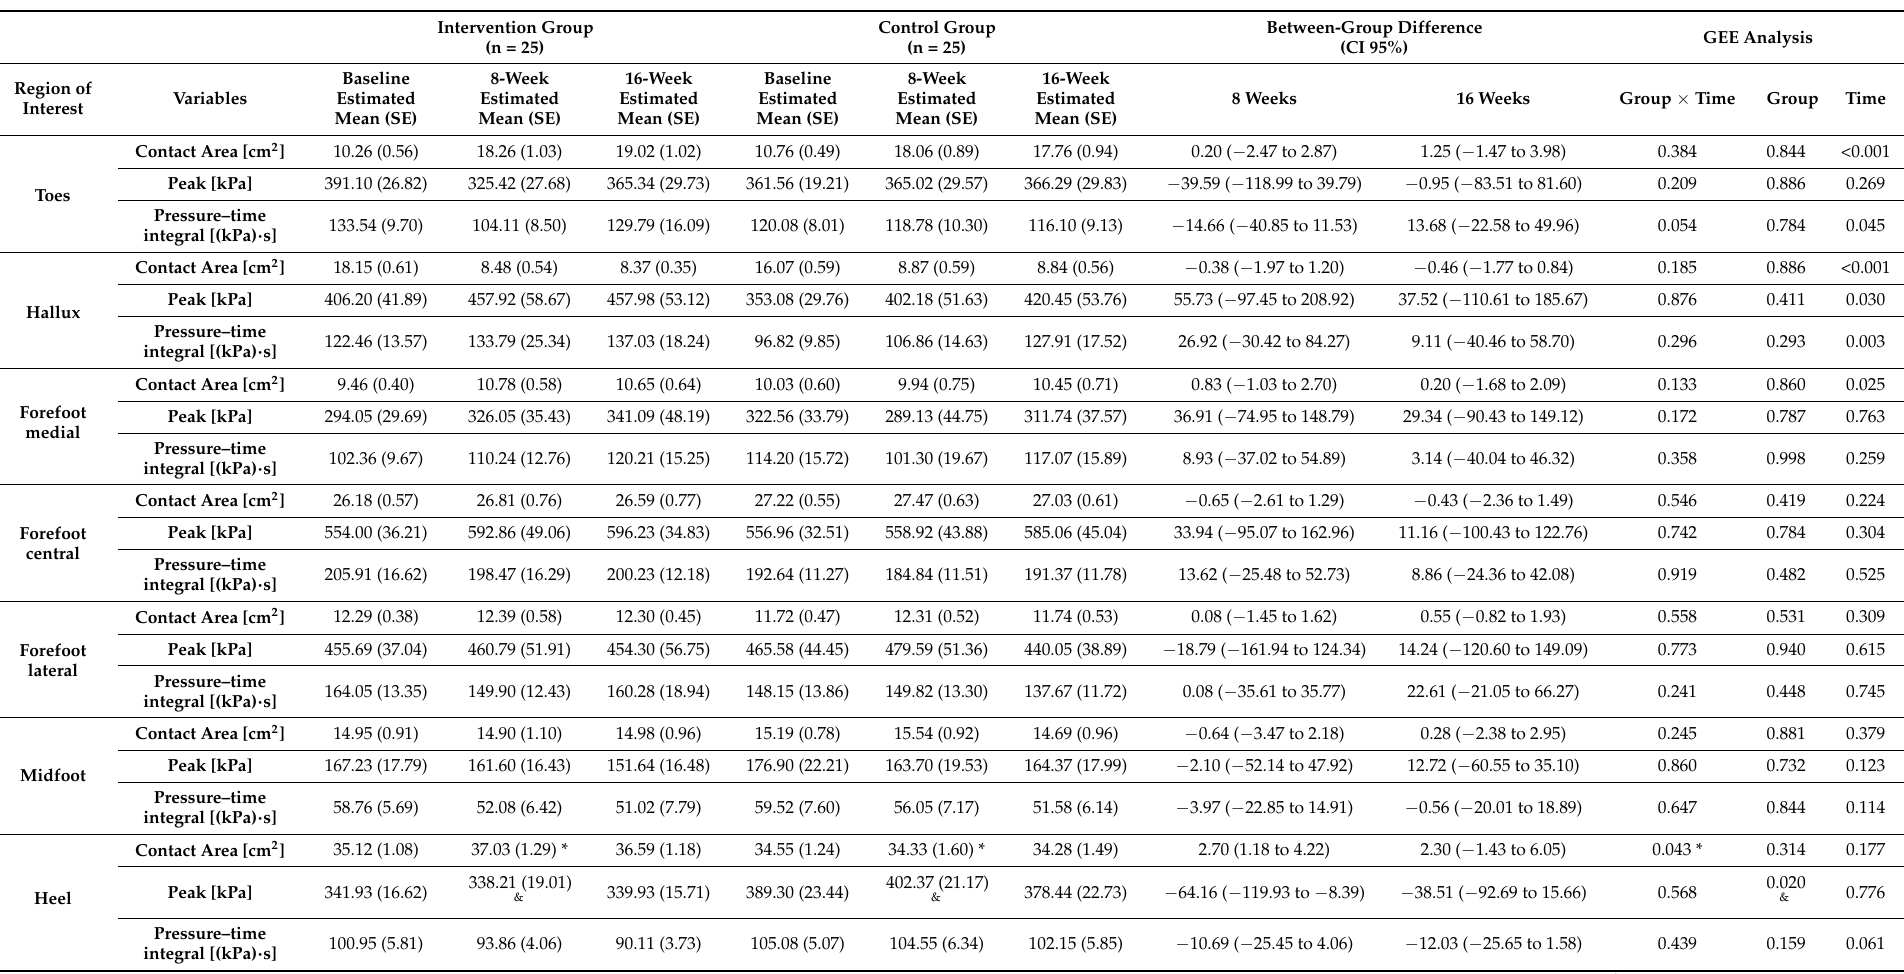
Table 3. Estimated mean (standard error, SE), p -values of the interaction, group and time effects, and between-group mean difference at 8 and 16 weeks (95% confidence interval) of the plantar pressure variables during gait for each group (control and intervention) at baseline and two follow-up assessments (baseline, 8 and 16 weeks). Intervention Group Control Group Between-Group Difference (n = 25) (n = 25) (CI 95%) GEE